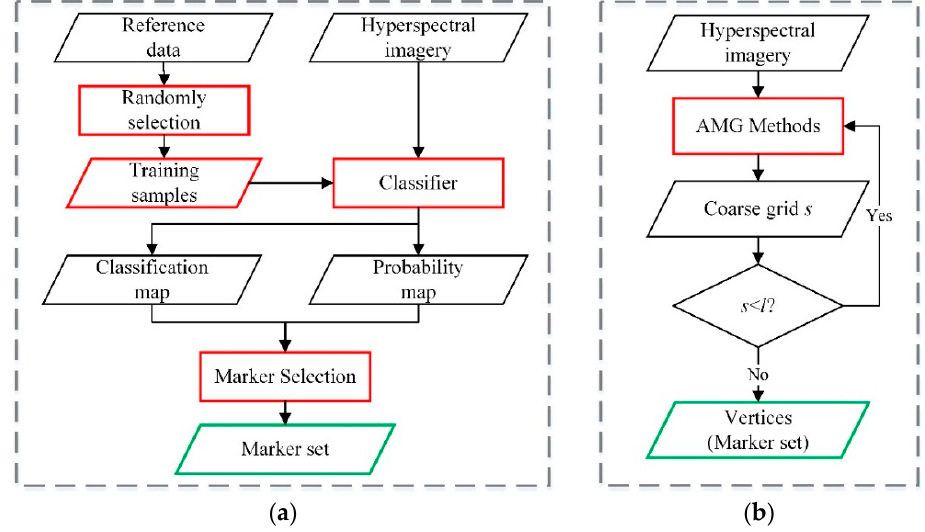
Figure 3. Flow-charts of the classification-derived marker selection method and our method: ( a ) the classification-derived marker selection scheme; and ( b ) the AMG-derived marker selection scheme.